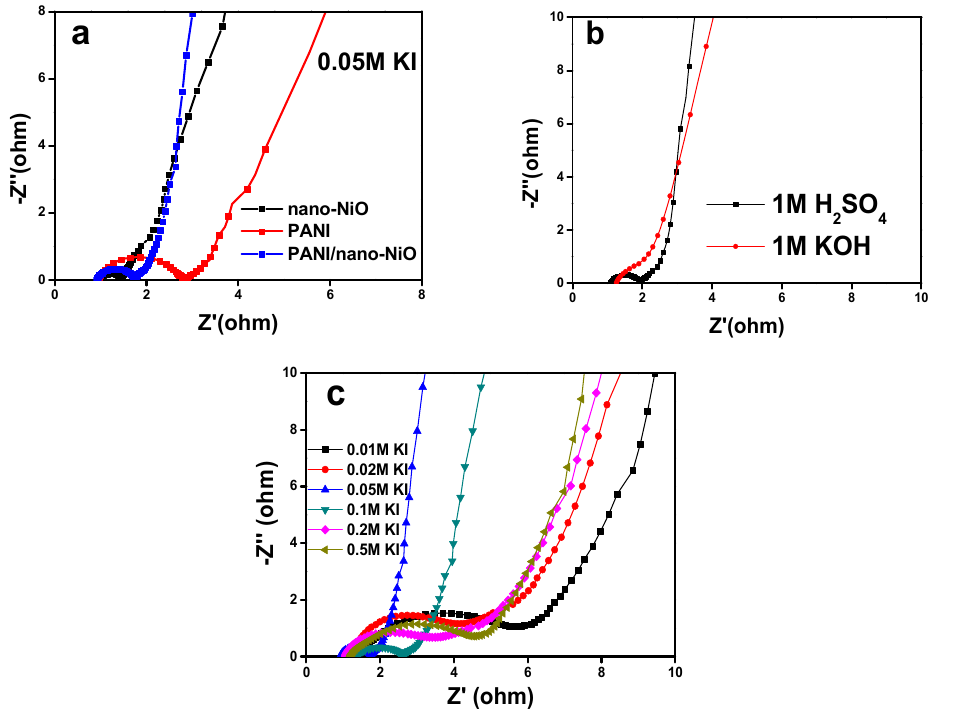
Figure 9. EIS curves in different electrolytes and concentration of KI. ( a ) 0.05 M KI. ( b ) 0 M KI. ( c ) 0.01–0.5 M KI. ( c ) 0.01–0.5 M